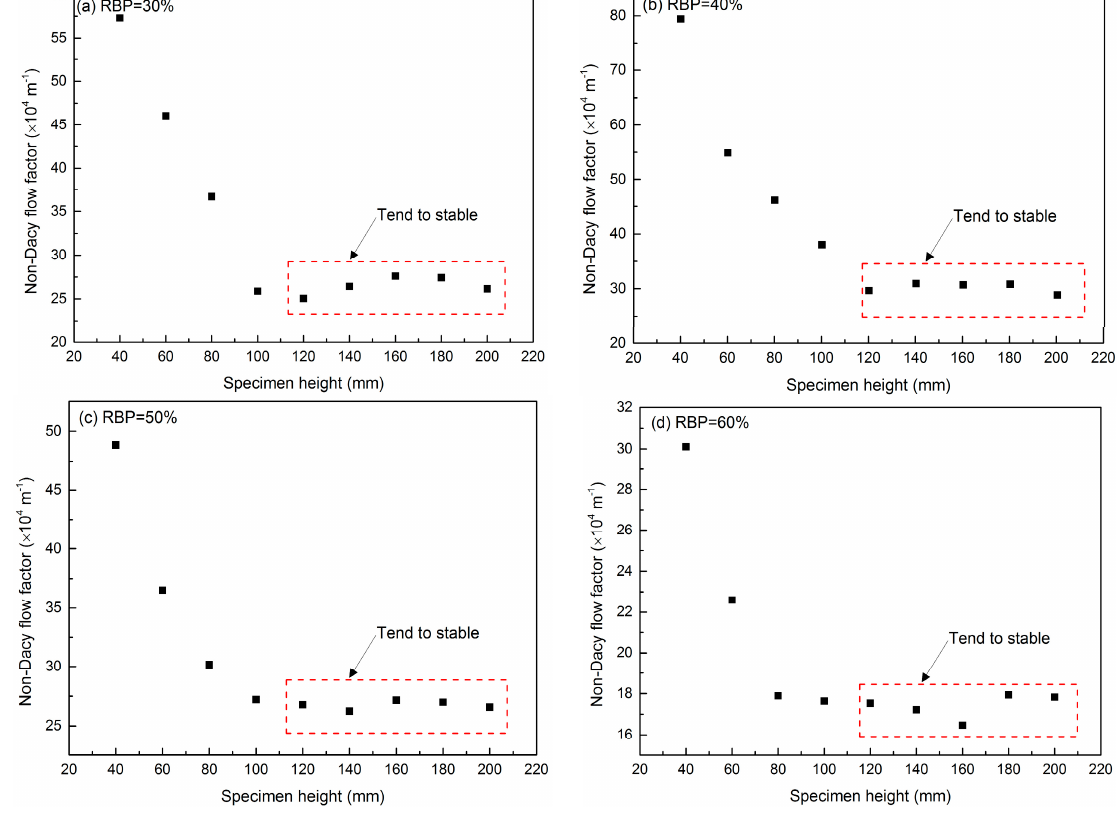
Figure 13. The plots of non-Darcy flow factor versus sample height against height for samples with RBPof30%, 40%, 50%, and 60%, respectively.